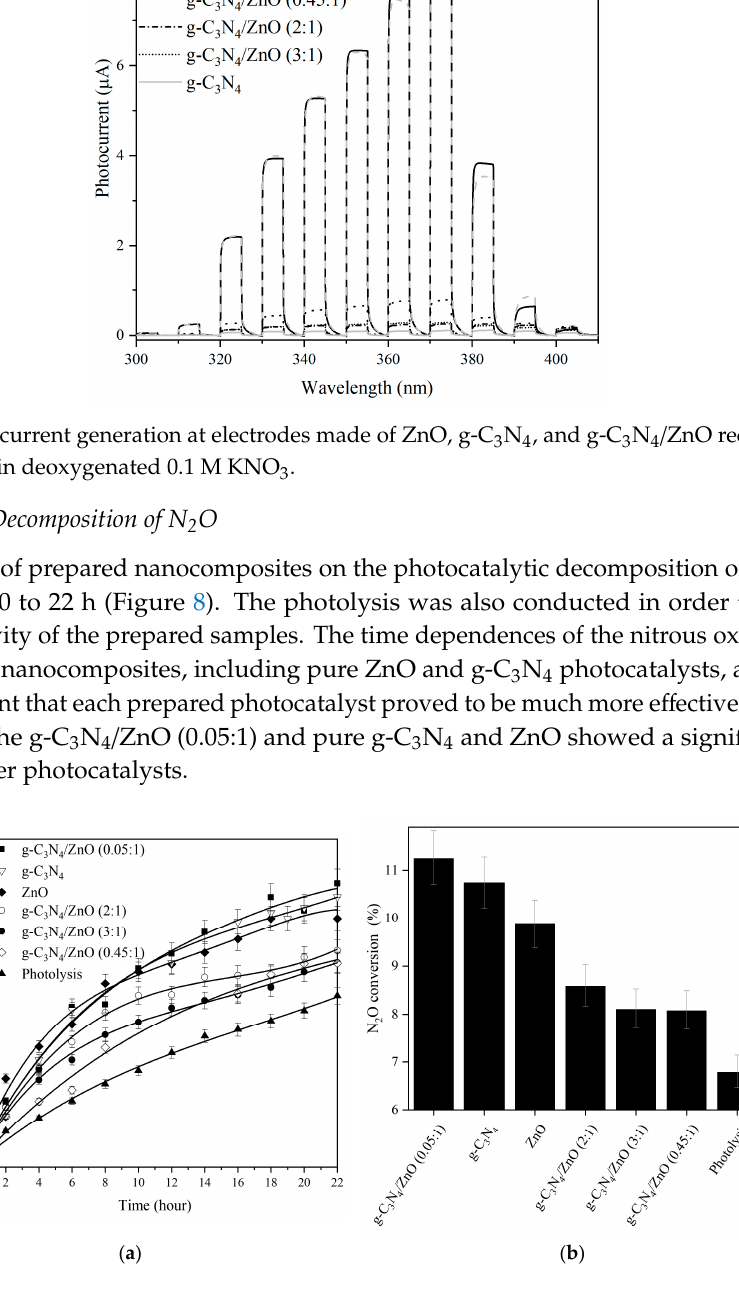
Figure 8. The time dependences of N 2 O conversion ( a ) and N 2 O conversion after 22 h of irradiation ( b ) over ZnO, g-C 3 N 4 and g-C 3 N 4 / ZnO and photolysis under UVA ( λ = 365 nm)